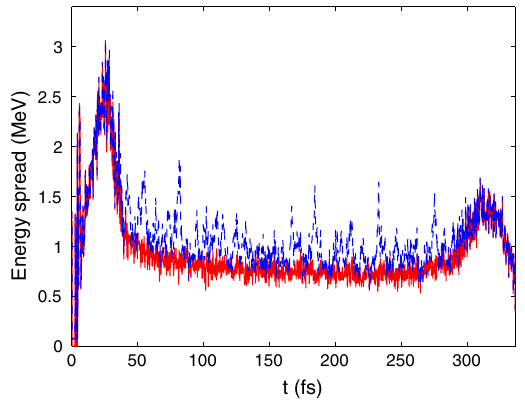
FIG. 6. Electron beam slice energy spread before (red solid line) and after (blue dashed line) the 8 undulator